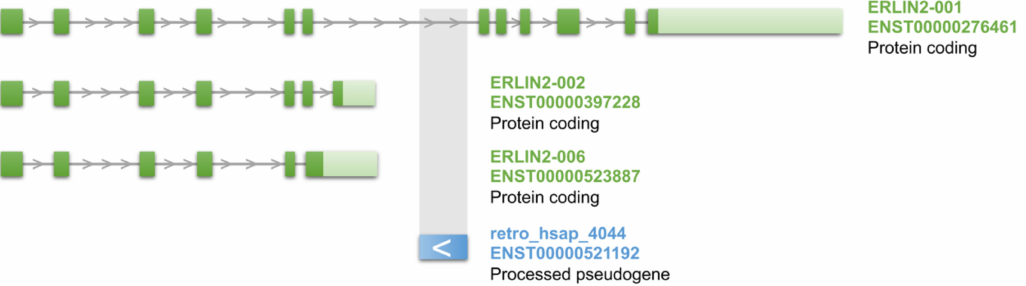
Figure 6. Three splicing variants of ERLIN2 gene (marked in green) and nested in the intron retrocopy (marked in blue). The retrocopy is located on the opposite DNA strand and according to Kaer et al. [104] expression of the retrocopy may facilitate early transcription termination and emergence of shorter